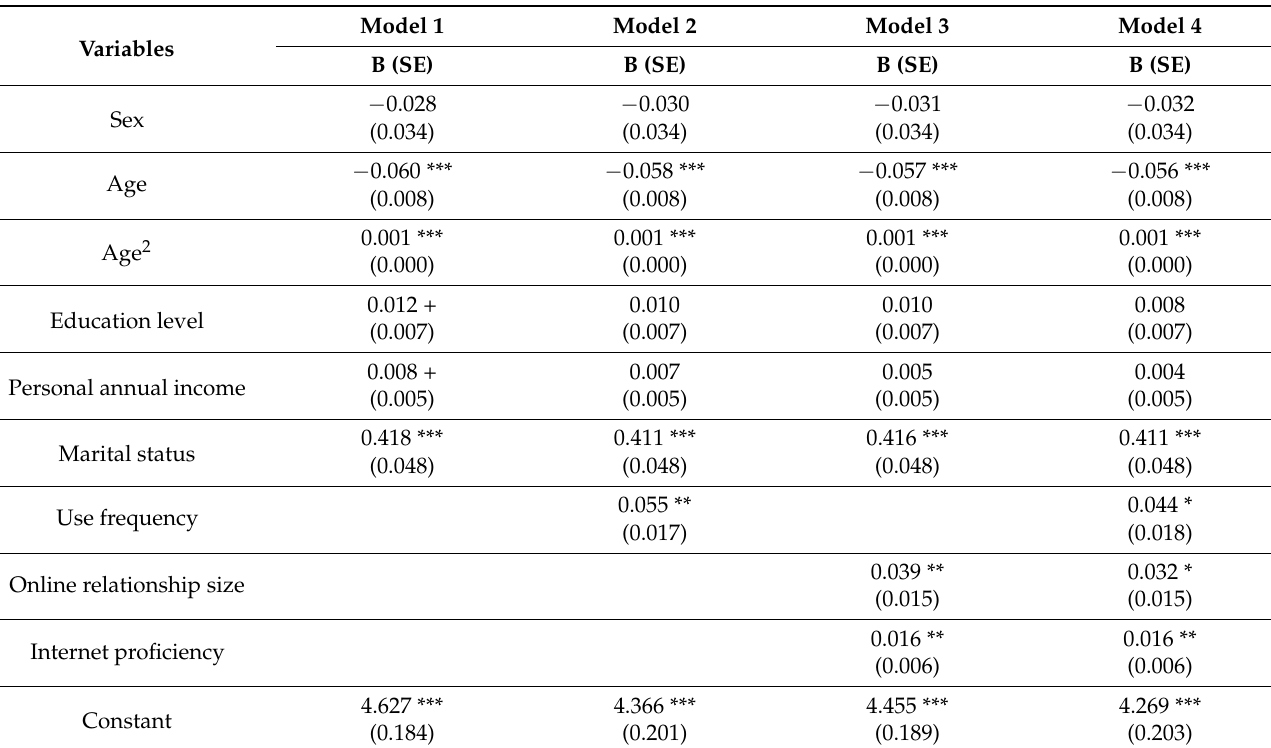
Table 2. Regression analysis showing the relationship between Internet use variables and subjective well-being (N =